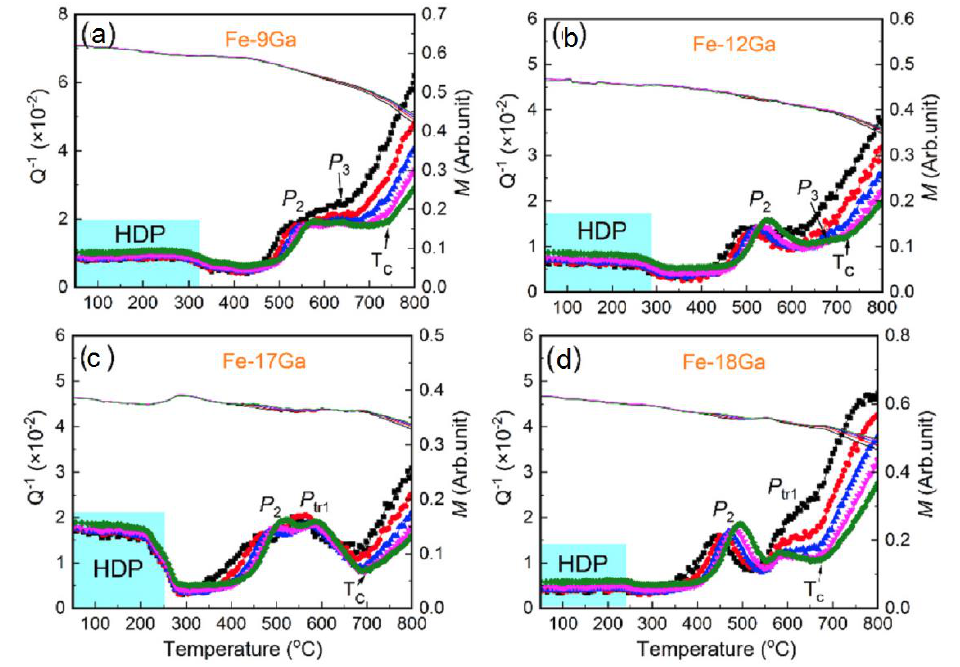
Figure 12. Selected TDIF curves for Fe–Ga alloys measured at torsion [61]. HDP indicates high damping plateau ( a – d ).